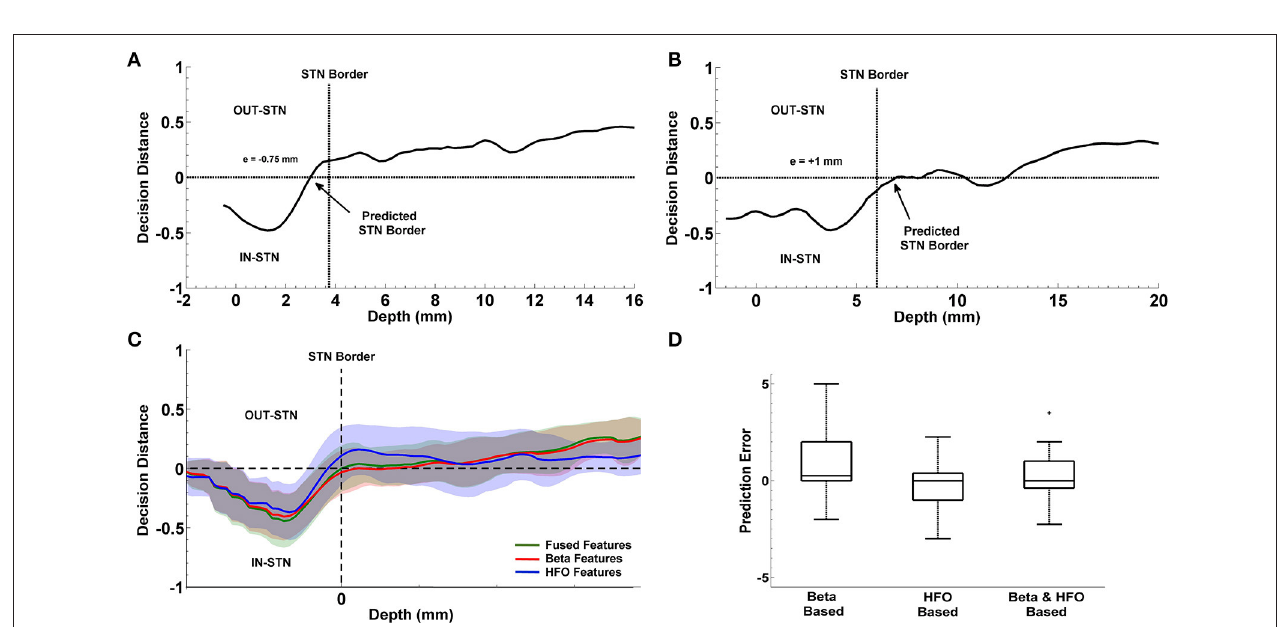
FIGURE 9 | Localization of dorsal border of STN. Panels (A,B) show the decision distances returned by the classifier voting either for IN-STN or OUT-STN for two representative subjects. Predicted STN border is shown with an arrow corresponds to the position where we find the maximum confidence point voted for IN-STN and trace back to the depth crossing zero. The black dashed lines indicate the dorsal border of STN obtained by MER/SUA. The predicted border is 0.75mm lower than the SUA-based border in the first subject (A) and 1mm higher in the second (B) . Panel (C) demonstrates the average border decisions with the standard deviation coming from all test subjects by using individual sub-band powers, beta (red) and HFO (blue), and fused features (green). (D) Comparison of prediction errors. The error (RMS) of the predictions obtained with beta and HFO band features are 1.98 and 1.18mm. The RMS of the error in predictions obtained from fused features is 1.22mm. The variance of RMS values were compared by F-test . The difference between beta-based and HFO-based prediction error is marginally significant ( p = 0.054 ) with α = 0.05. + indicates the outlier error